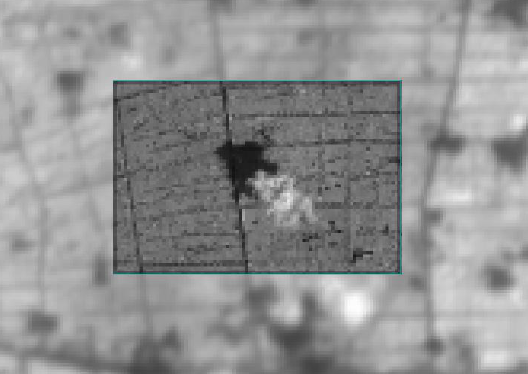
Figure 9. 60 m resultant images of August 29